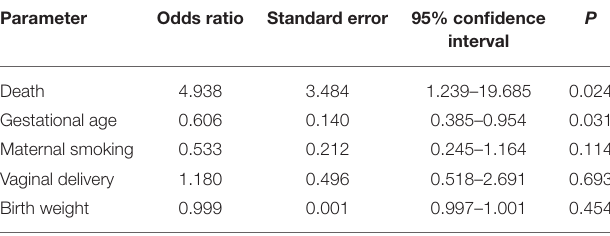
TABLE 3 | Logistic regression analysis of factors associated with FT4 ≤ 10 pmol/L in multivariate analysis (overall model fit, p < 0.001). Parameter